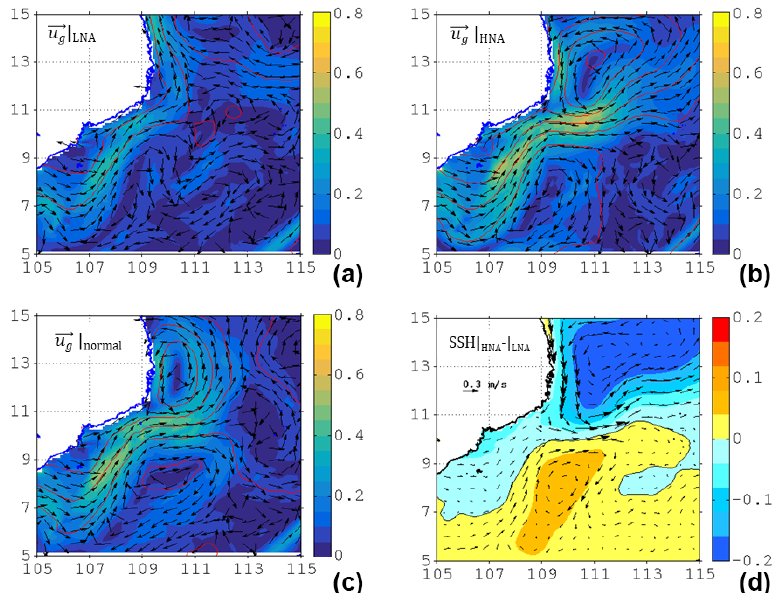
Figure 8. Same as Fig. 4 but based on model